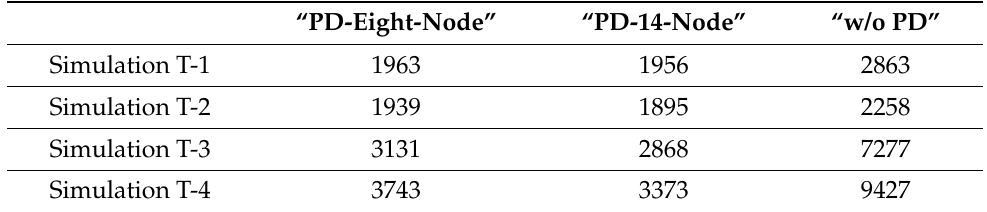
Table 7. Training duration when performance reaches KSP-FF (in